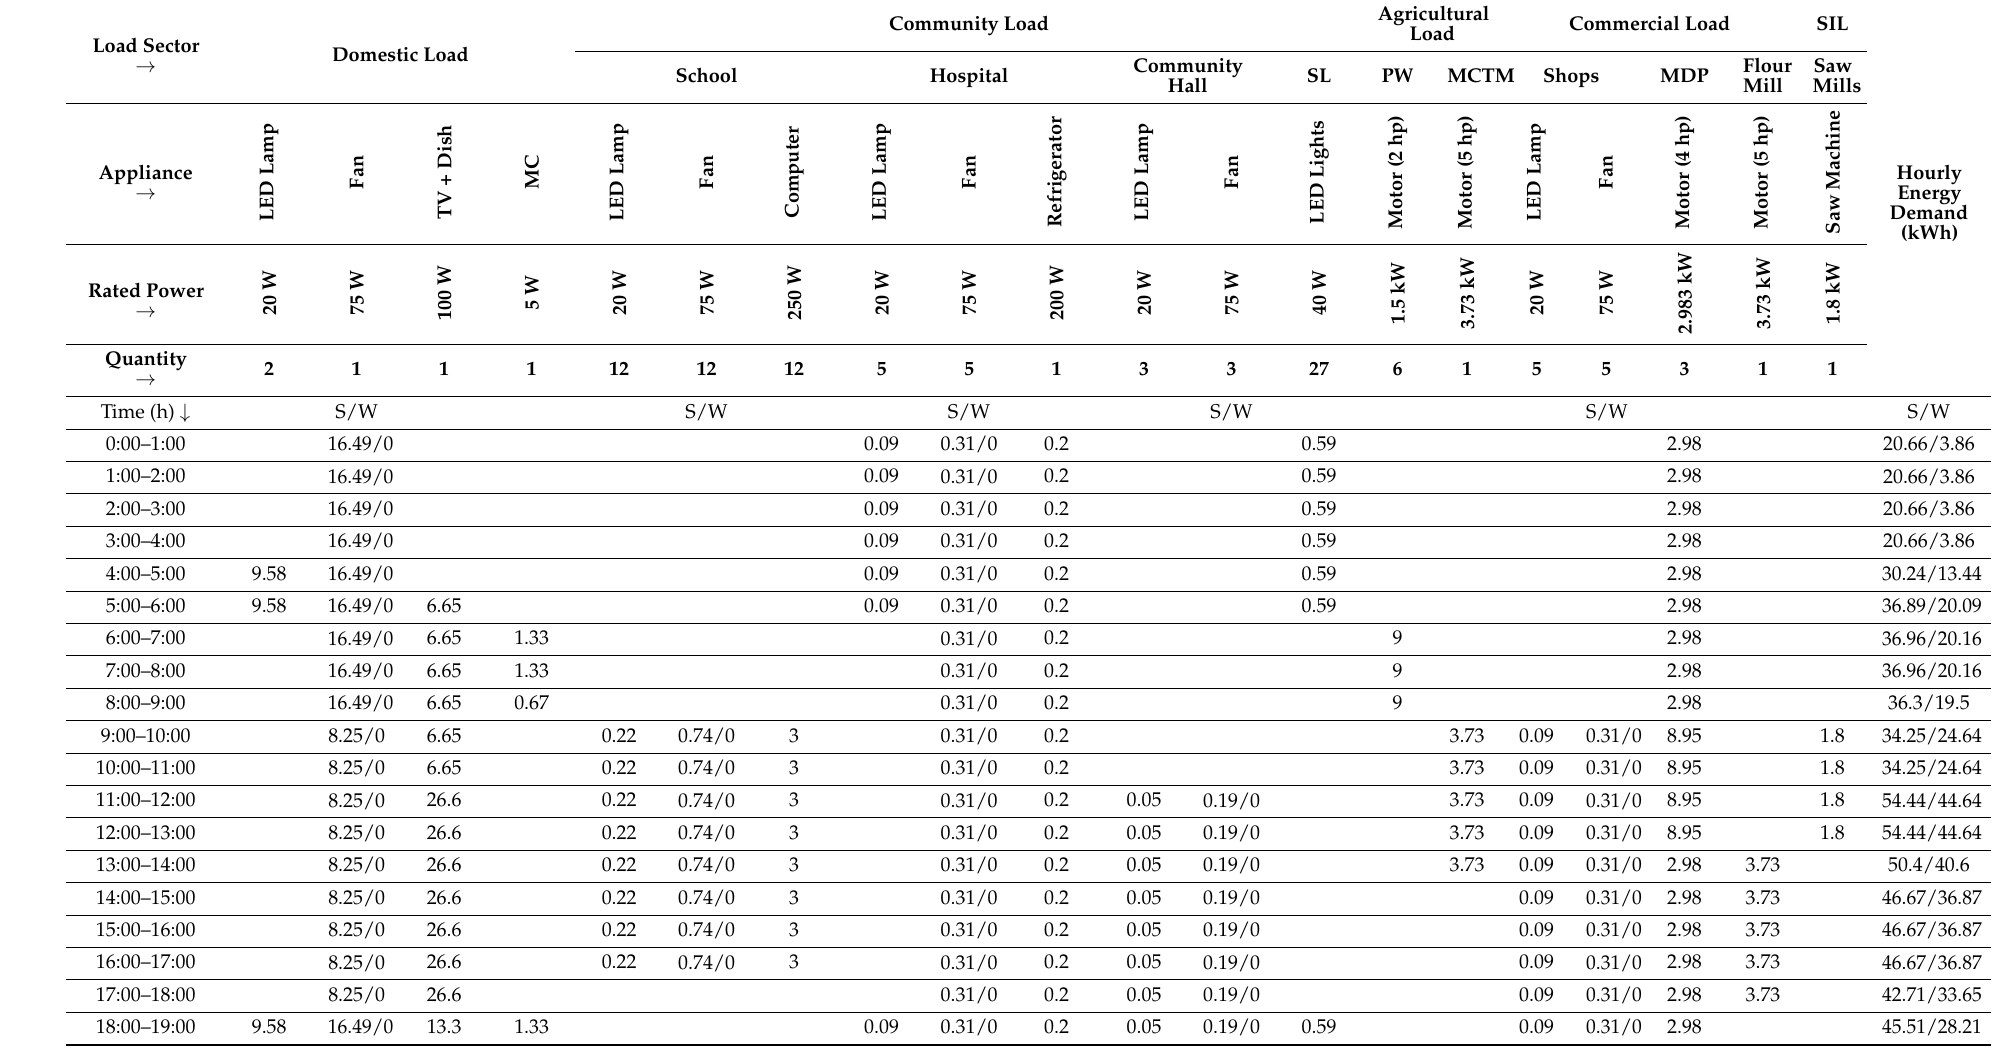
Table 2. MPRAMC-based scenario load demand for both winter and summer